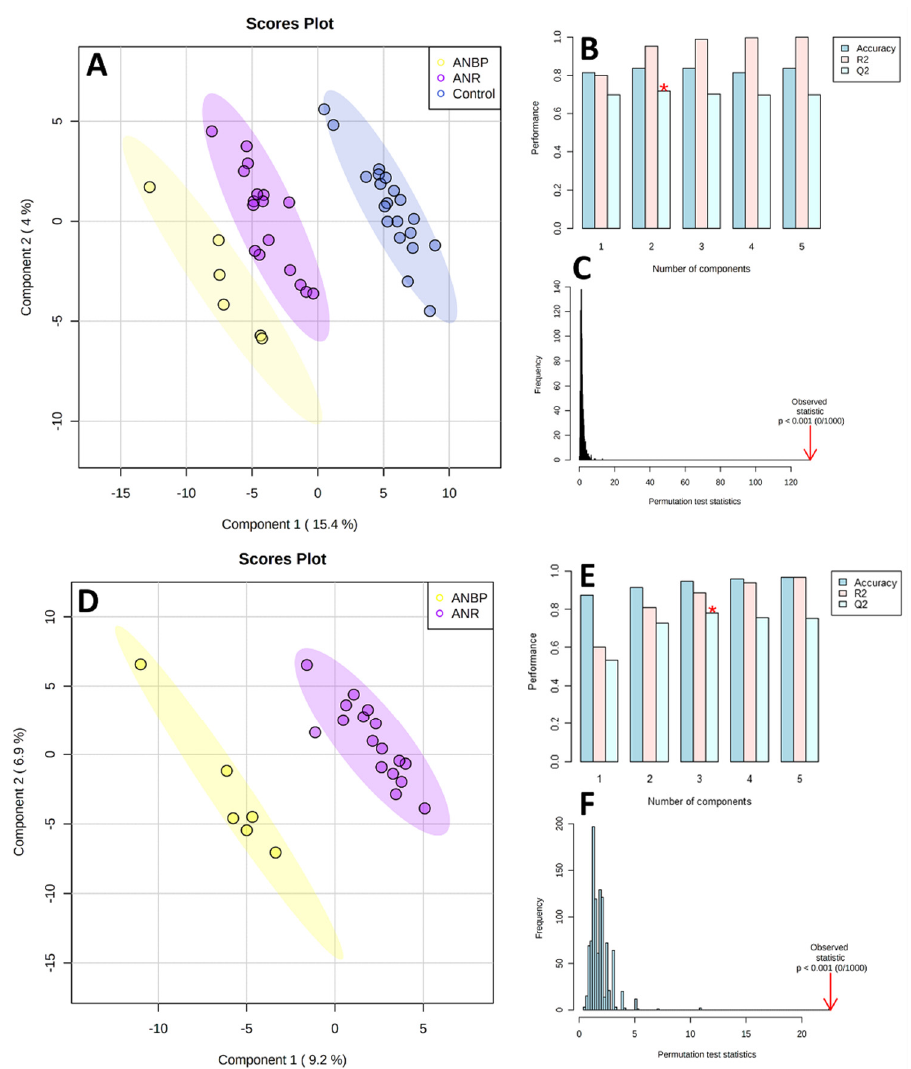
Figure 1. Partial least square discriminant analysis (PLS-DA) models to discriminate healthy controls (CTRL), restricting (ANR), and binge-purging (ANBP) anorexia nervosa patients ( A ) and ANBP and ANR patients ( D ). The explained variance of each component is shown in brackets on the corresponding axis. ( B , E ) Accuracy, R 2 , and Q 2 results estimate via cross-validation. Q 2 is an evaluation of the predictivity ability of the model. In each cross-validation, the predicted data are compared with the original data, and the sum of squared error is calculated. The better prediction performances are provided by the model, with three components providing for the higher Q 2 (marked with a red star). ( C , F ) Permutation test results based on 1000